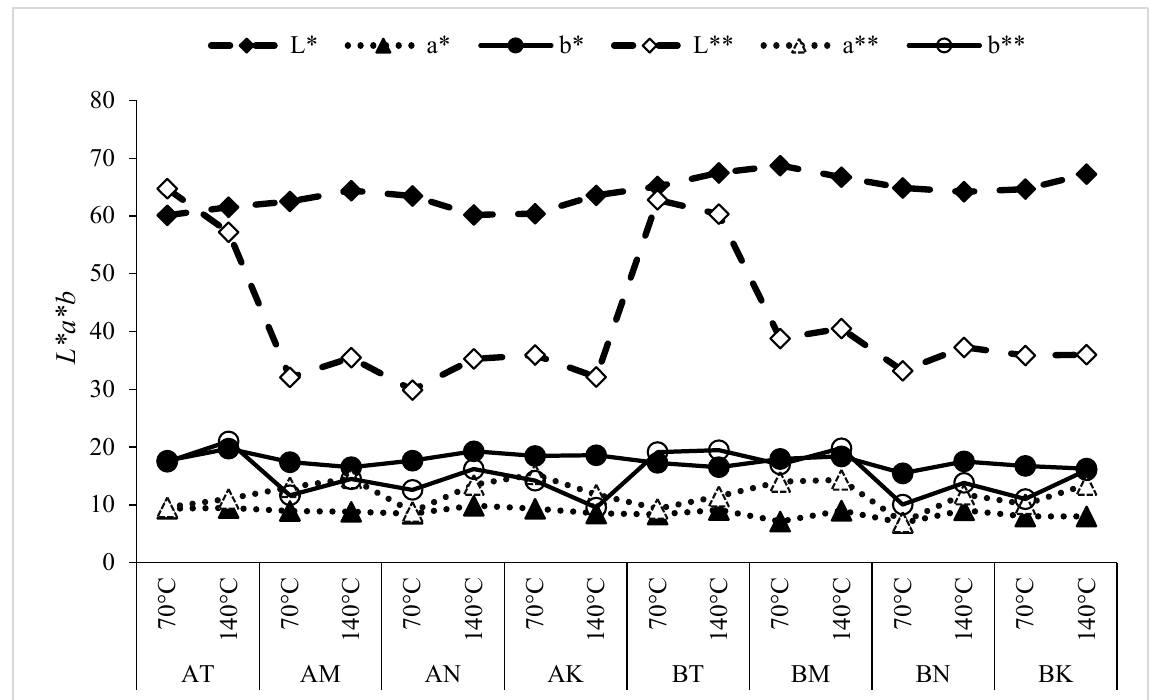
Figure 2. The L*a*b values of manii wood after heating at 70 or 140 °C, and treatments with boric acid (B), without boric acid (A), with neem oil (M), with tamanu oil (N), with candlenut oil (K), and without oil (T).